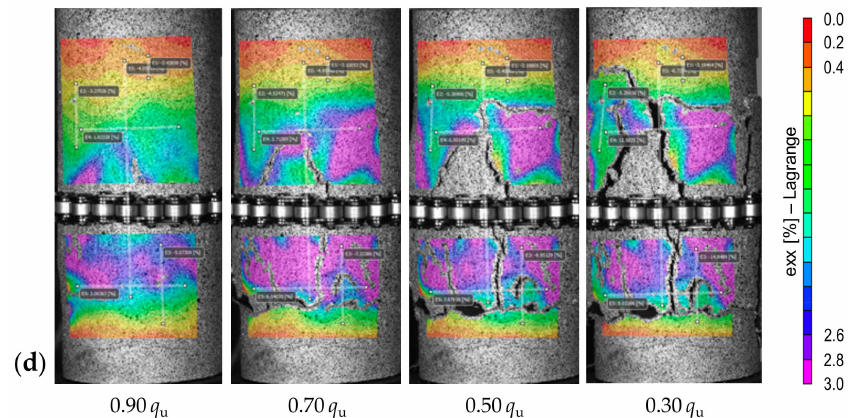
Figure 6. Field of strains developed at various axial stress levels for the sample P 4 F 0 T 14 : ( a ) Axial pre-peak; ( b ) Axial post-peak; ( c ) Lateral pre-peak; and ( d ) Lateral post-peak.